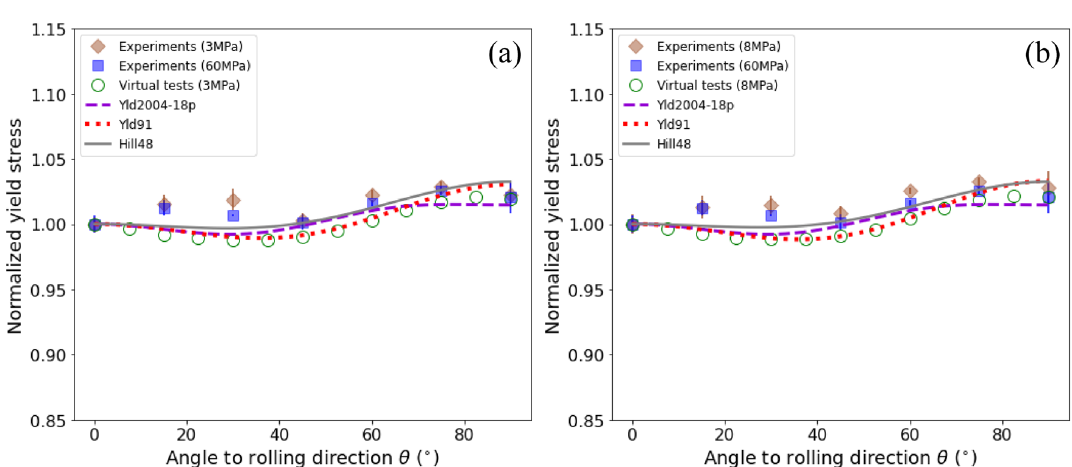
Figure 9. Normalized yield stress Y θ versus θ of the DP980 sheet at deformation stages with the specific plastic work of ( a ) 3 MPa and ( b ) 8 MPa. The lines are the predicted results of the calibrated yield functions. The diamonds and squares represent experimental values at an interval of 15° from RD to TD and the open circles are the results obtained from virtual tests of uniaxial tension at an interval of 7.5° from RD to